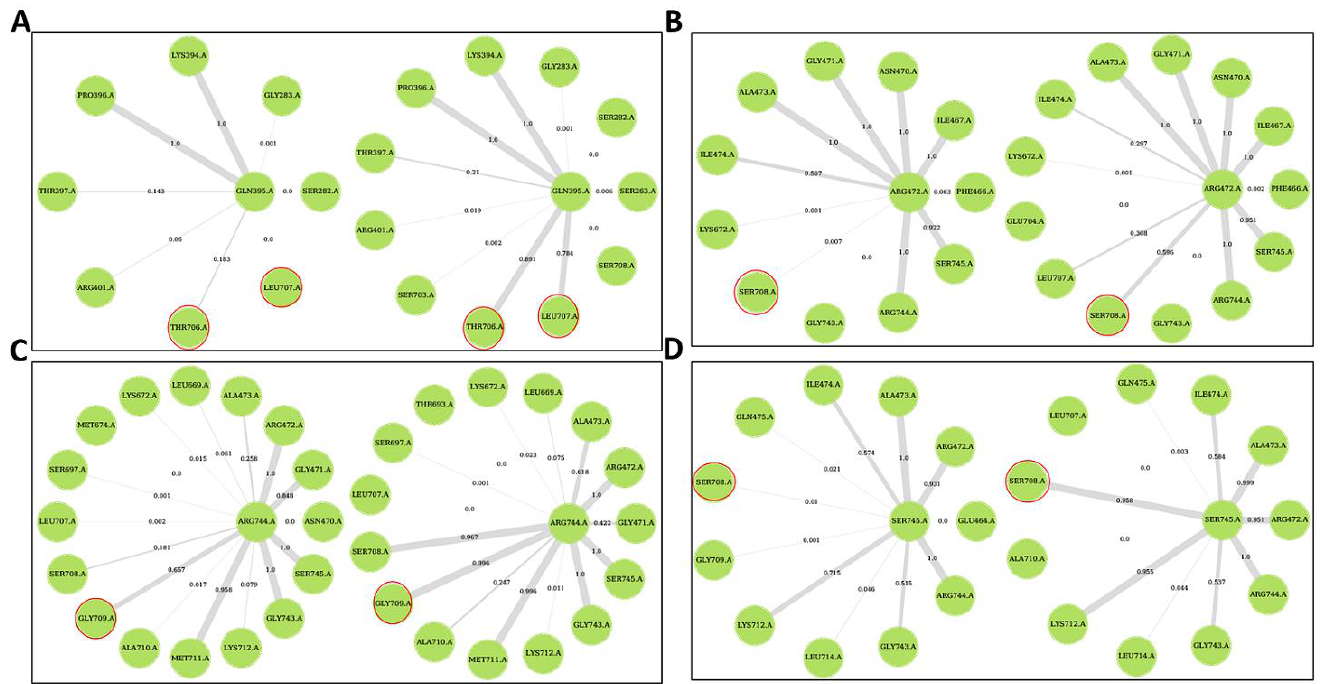
Figure 13. Frequency of contacts at the determined allosteric site in the holo (left sub-figure) and the ligand-bound complexes (right sub-figure). The allosteric site residue is shown in the middle of each contact map while residues at the Z-domain are circled in red. ( A ) Contact frequency between Gln395, Thr706 and Leu707, ( B ) Contact frequency between Arg472 and Ser708, ( C ) Contact frequency between Arg744 and Gly709 and ( D ) Contact frequency between Ser745 and Ser708.